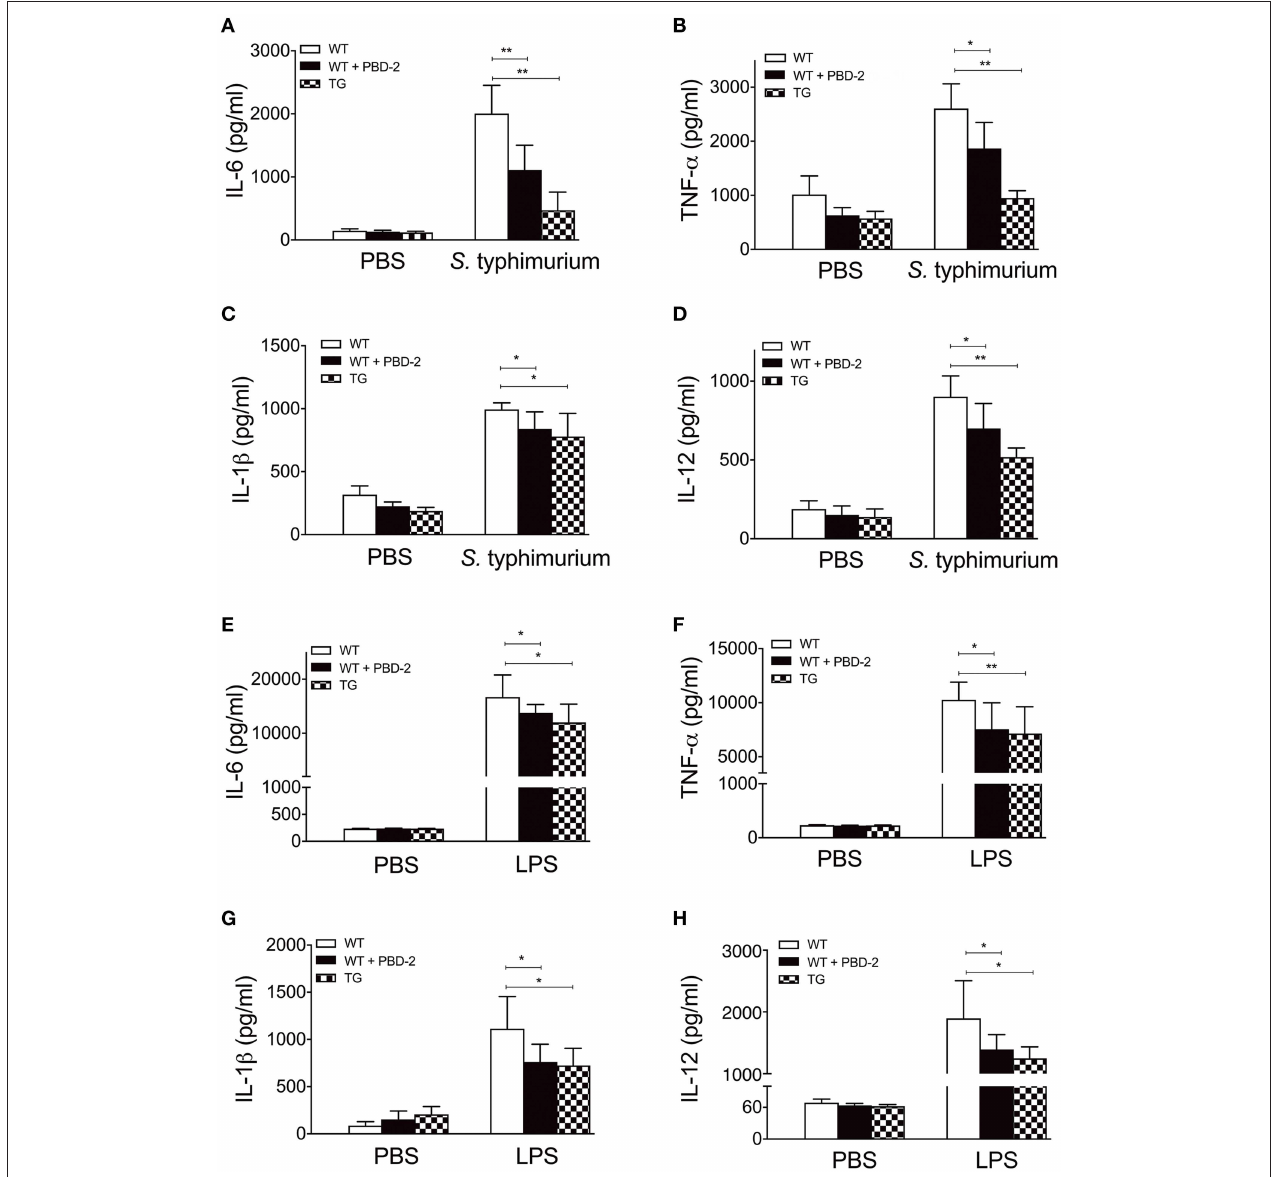
FIGURE 4 | PBD-2 could alleviate S. Typhimuriumi- and LPS-induced inflammation. TG and WT mice were orally administered with 2.5 × 10 8 CFU of S. Typhimurium. In another group, WT mice were orally administered with 2.5 × 10 8 CFU of S. Typhimurium together with PBD-2. At 24h post-infection, blood samples of the mice were collected for detection of cytokines (A–D) . In another experiment, WT mice, TG mice, and WT mice treated with PBD-2 were injected with LPS (16 µ g/g). The blood samples were collected from the mice 1h after the injection to detect cytokines (E–H) . Mice treated with PBS were used as negative control. The proinflammatory mediators TNF- α , IL-6, IL-1 β , and IL-12 in the mice serum were examined by ELISA. Data are represented as means ± SD (WT, n = 6; TG, n = 6). * p < 0.05, ** p <